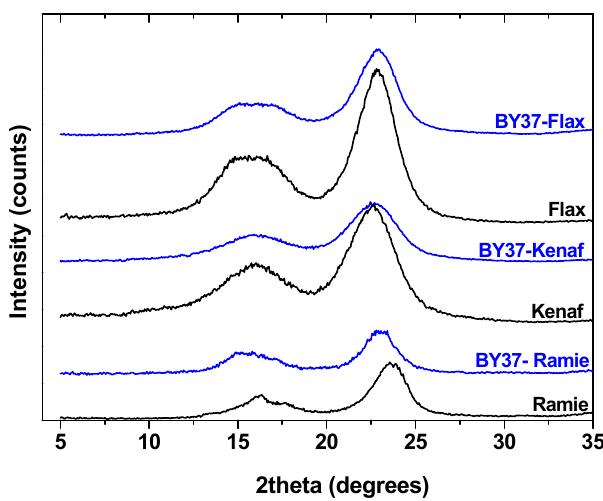
Figure 2. XRD patterns of kenaf fiber, BY37-kenaf, ramie fiber, BY37-ramie, flax fiber, and BY37-flax.